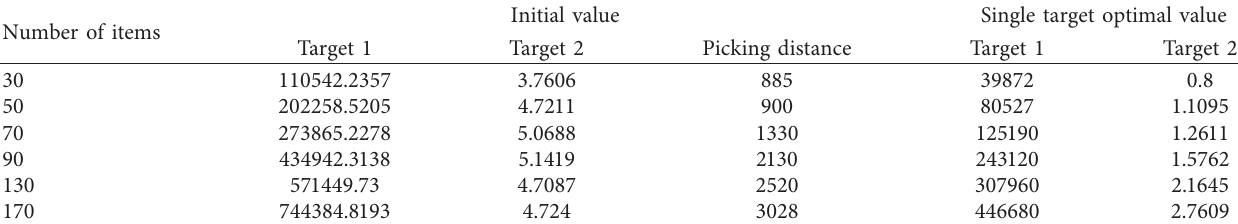
Table 4: The initial and the optimal values of each single target.